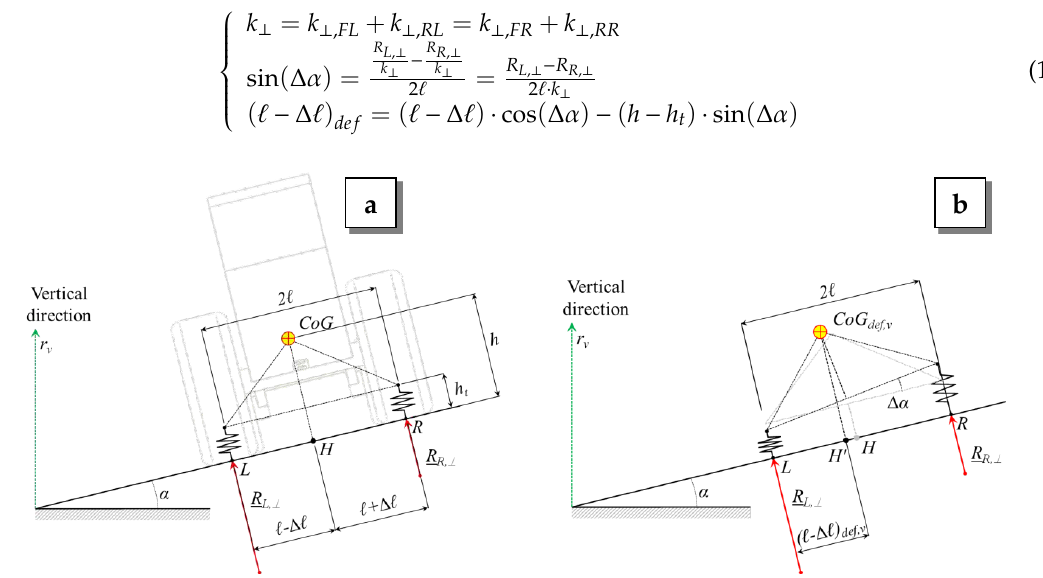
Figure 13. Graphical representation of the effect of a pure compression of the tyres due to the weight component in the direction perpendicular to the support plane, supported by each tyre ( a : initial situation–tyres not deformed; b : final situation–tyres deformed).